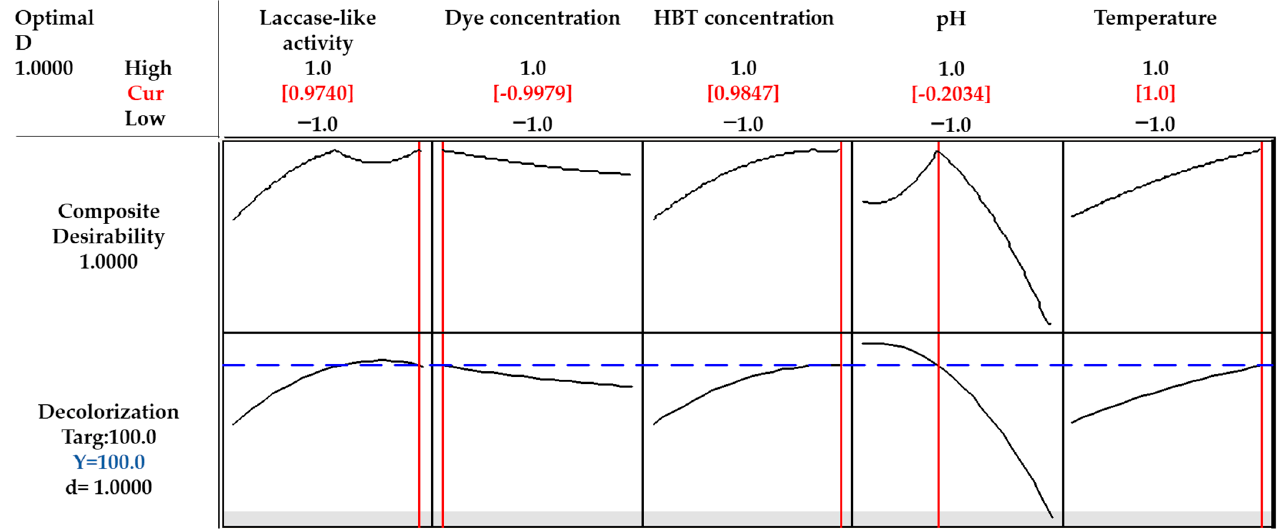
Figure 4. Optimized condition-set for RB5 decolorization obtained with Minitab 16 statistical soft- ware.